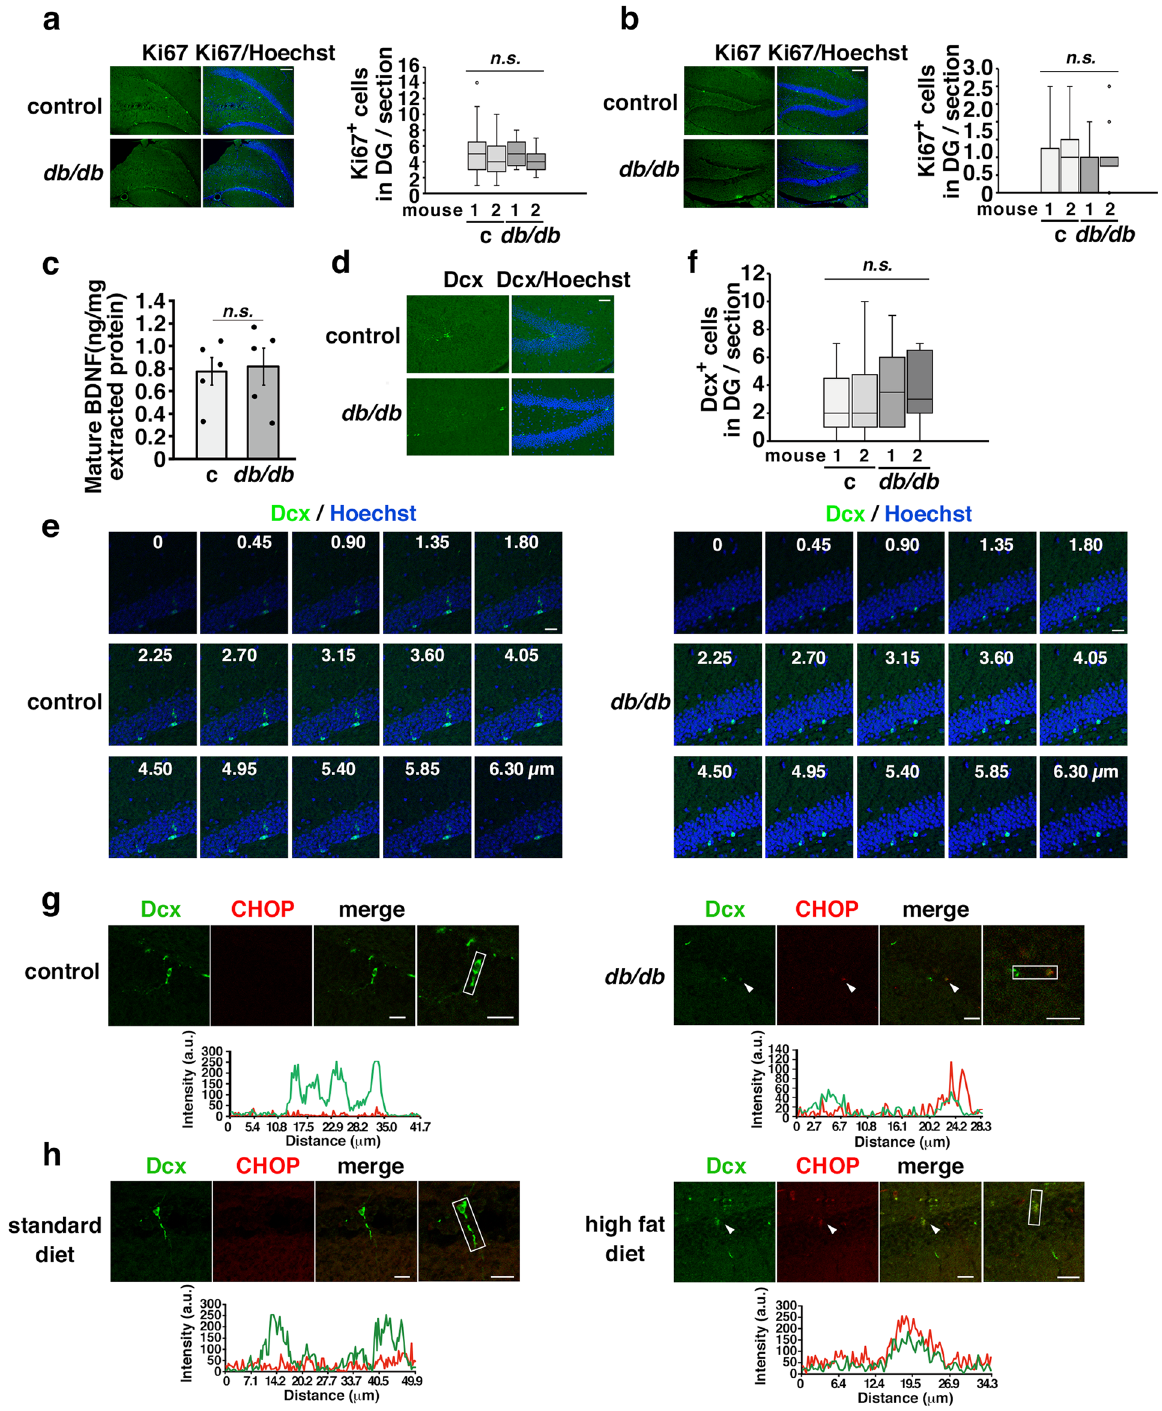
Figure 3. CHOP and Dcx were coexpressed in the immature neurons of mice with long-term obesity. ( a , b ) Ki67-positive ( +) cells in the SGZ of the DG/section in 10-week-old (c: control mice, n = 2; db/db mice, n = 2,) ( a ) and 45-week-old (control mice, n = 2; db/db mice, n = 2) ( b ) db/db mice. Scale bars: 100 µm. The box-and-whisker plot represents the number of cells per section from each animal. Statistical significance ( p < 0.05) was determined by one-way ANOVA followed by the Bonferroni post-hoc test. ( c ) Mature BDNF expression in the hippocampi of 46-week-old mice. Control mice (n = 5); db/db mice (n = 5). Statistical significance ( p < 0.05) was determined by Student’s t test. ( d–f ) Number of Dcx + cells in the DG/section in 45-week-old control and db/db mice. Serial sections of the DG from zero to 6.30 µm imaged by confocal microscopy. Scale bars: 40 µm ( d ); 20 µm ( e ). The box-and-whisker plot represents the number of cell per section from each animal. Control mice (n = 2); db/db mice (n = 2) ( f ). Statistical significance ( p < 0.05) was determined by one-way ANOVA followed by the Bonferroni post-hoc test. ( g , h ) CHOP was expressed in the Dcx-expressing neurons in 45-week-old db/db mice ( g ) and 69- to 71-week-old APP23 mice with long-term HFD-induced obesity (h). ( g ) Control mice (n = 2, 12 brain slices); db/db mice (n = 2, 12 brain slices). ( h ) Standard diet APP23 mice (n = 2, 8 brain slices); high fat diet APP23 mice (n = 3, 12 brain slices). The arrowheads in each panel indicate Dcx- and CHOP-positive cells. Scale bars: 20 µm. The fluorescence intensity profiles are shown in the square boxes (bottom